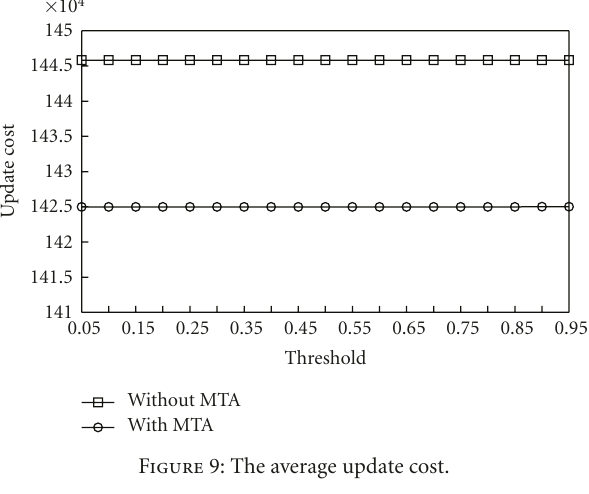
Figure 9: The average update cost.